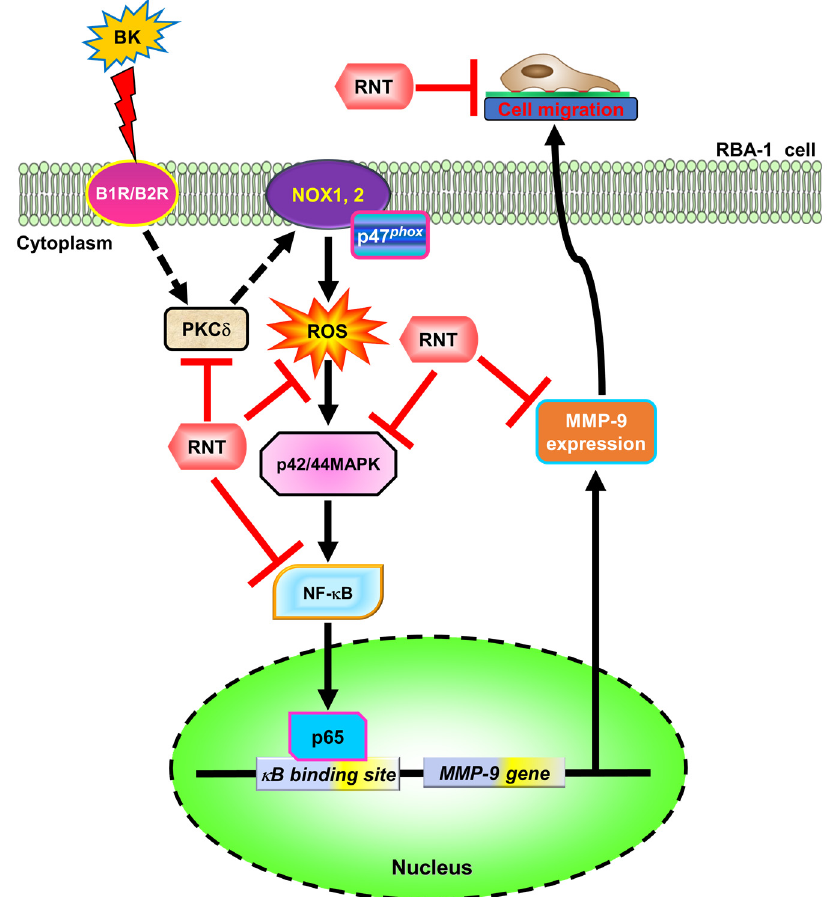
Figure 7. The schematic signaling pathways contribute to the effects of RNT on the BK-induced MMP-9 expression in RBA-1 cells. RNT blocks PKC δ /NADPH oxidase/ROS generation/p44/p42-dependent NF- κ B p65 binding with MMP-9 promoter induced by BK, leading to attenuating MMP-9 expression and cell migration of RBA-1 cells. “ → ” means “activated”; “ ⊥ ” means “inhibited”.